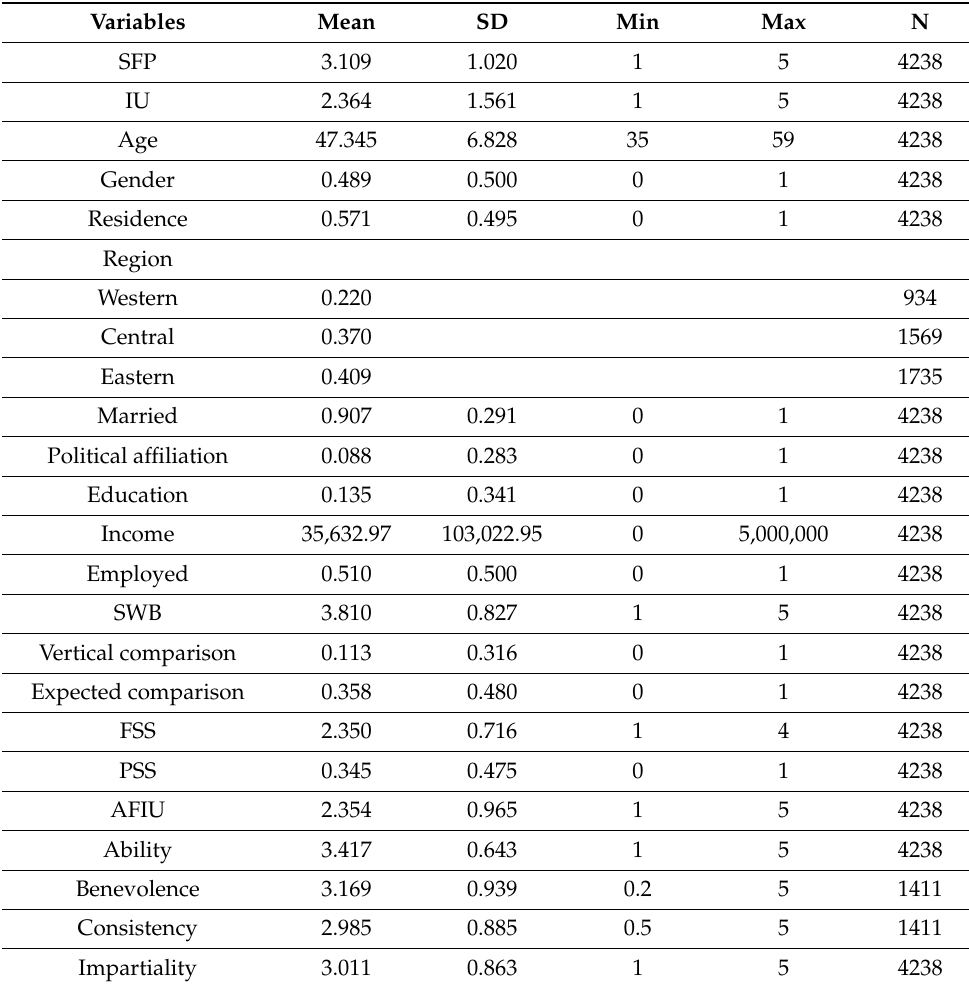
Table 1. Descriptive